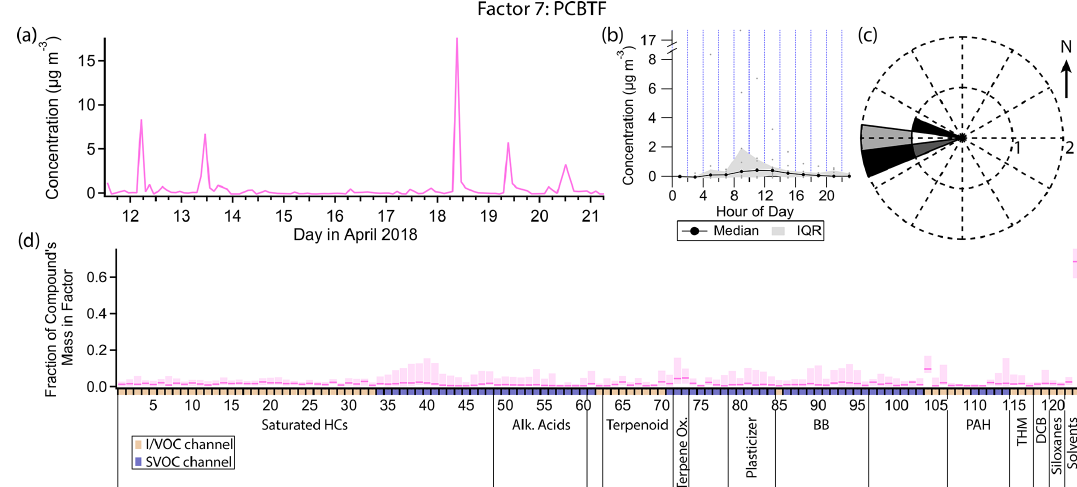
Figure 12. (a) Factor 7 timeline. (b) Diurnal profile for Factor 7. (c) Rose plot showing correlation of elevated emissions and wind direction. (d) Factor 7 composition profile. See Fig. 4 description for further information on how to read this figure.